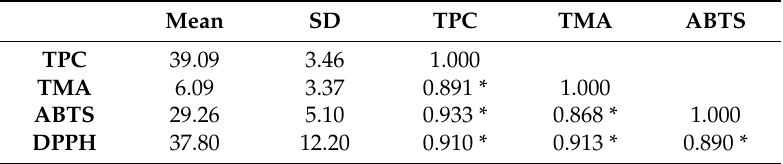
Table 3. The significance of correlation coefficient from RSU of the total phenolic content (TPC), total monomeric anthocyanin (TMA) and radical scavenging activity (ABTS and DPPH) for the Brosimum alicastrum left-extract. Mean SD TPC TMA